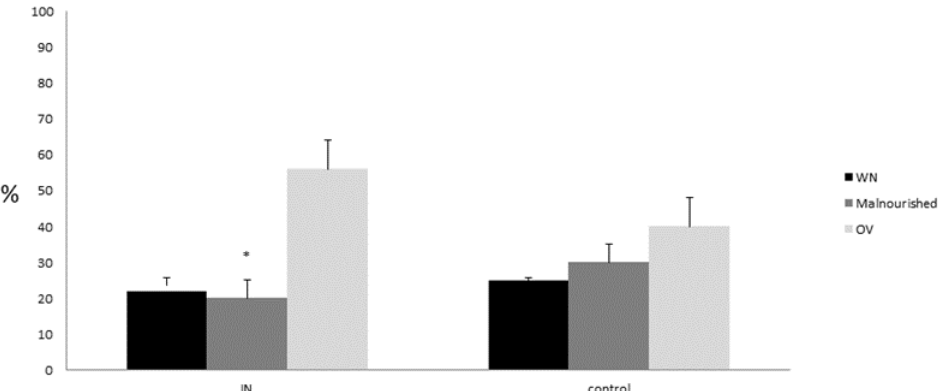
Figure 4. T1 nutritional status changes in the IN and control group. Malnutrition prevalence was significantly higher in the control group vs. IN treated-one. * p < 0.05. Semi-intensive unit days of stay were not affected by IN use ( p = NS).